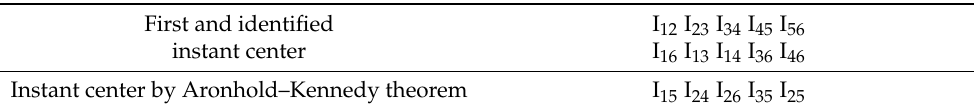
Table 7. Instant centers of six-bar planar linkage with Criterions 1 and 2. First and identified